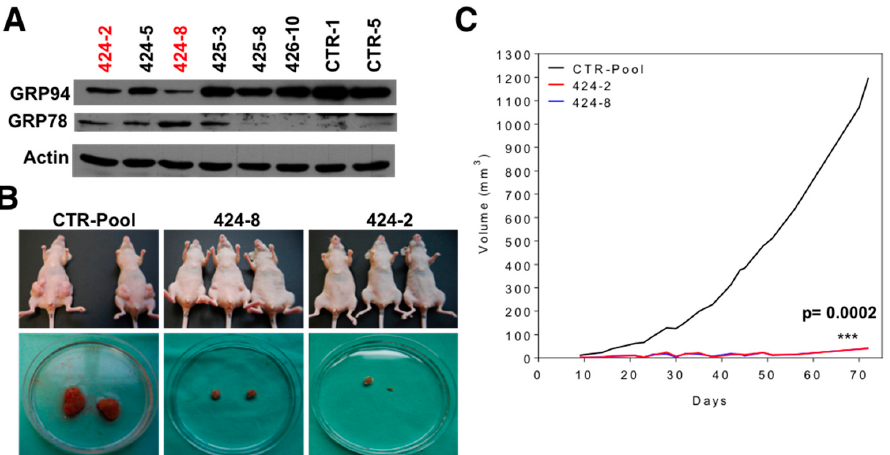
Figure 5. Glucose-regulated protein 94 (GRP94) deletion reduces tumorigenic efficiency in an orthotopic model. ( A ) Immunoblotting of GRP94 and actin shows efficient GRP94 knockdown in BRV5CA1 cells. ( B ) Nude mice were injected in the mammary fat pad with control (BRV5CA1